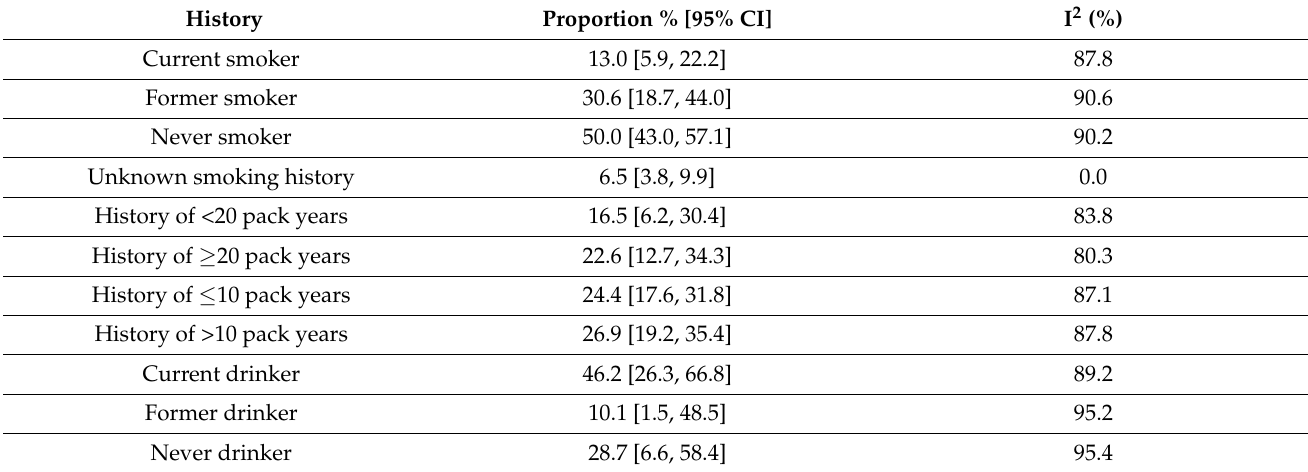
Table 3. Meta-analysis of tobacco and alcohol history and I 2 values amongst 28 studies ( n =